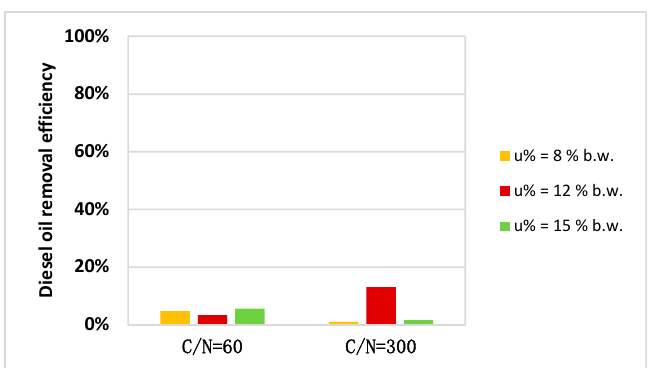
Figure 5. Diesel oil removal efficiency (C/N = 60 and C/N = 300, t = 35 days).